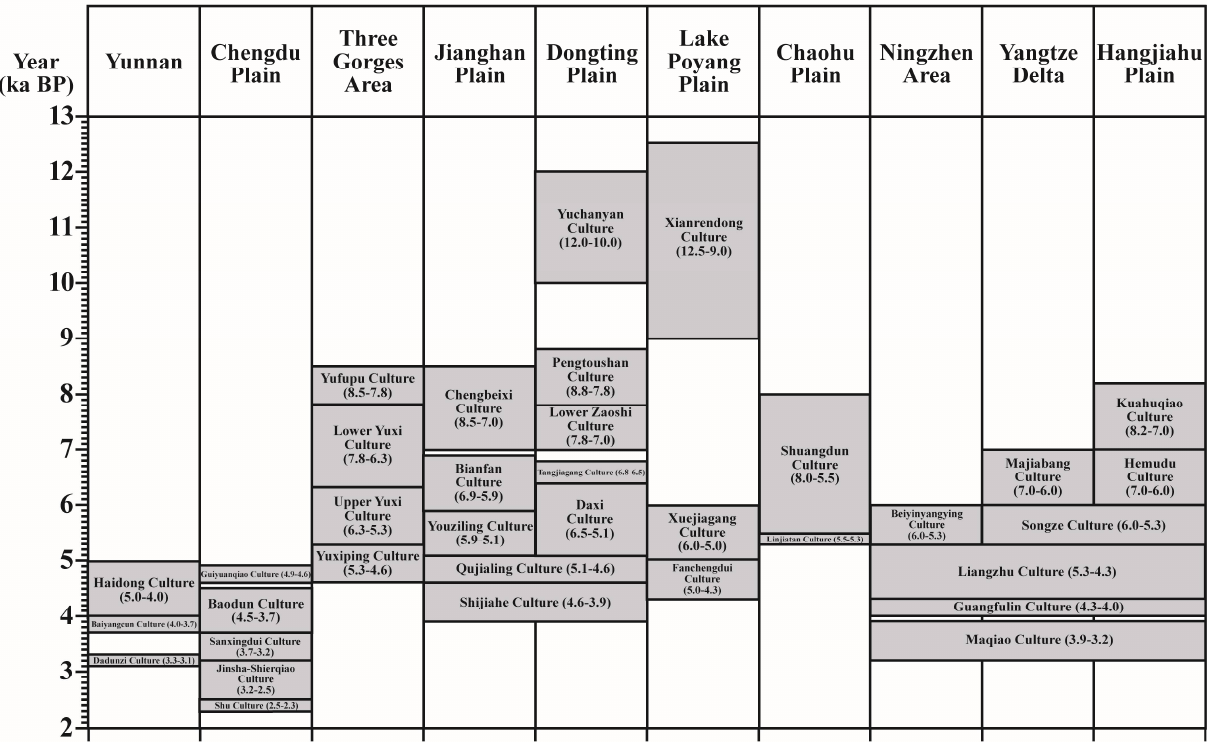
Figure 2. Main Neolithic and Bronze cultures of ten areas of the Yangtze River